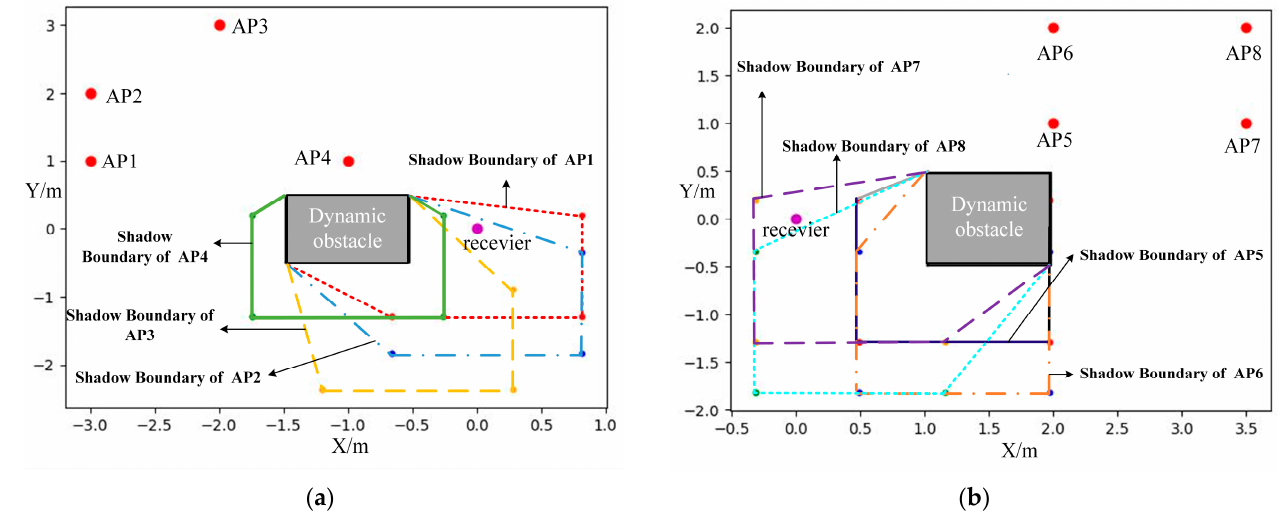
VLC link of AP3, AP4, AP5, AP6 and AP8 are not blocked by dynamic obstacles. There- Figure 8. Shadows of APs under the influence of static obstacle: ( a ) AP1-AP4; ( b ) AP5-AP8. fore, the theoretical value is consistent with the simulation value. Under the influence of dynamic obstacles, the shaded areas of different APs are shown in Figure 9. It can be seen from the figure that the receiver is in the shadow of AP1, AP2 and AP7. The receiver is not in the shadow of AP3, AP4, AP5, AP6 and AP8. Accord-